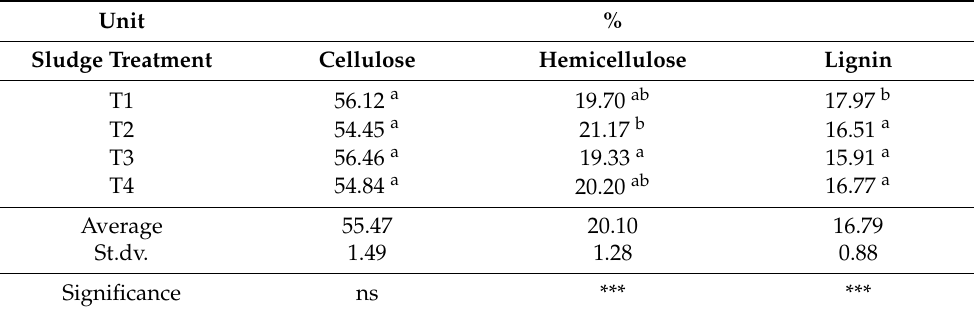
Table 7. Structural composition of Virginia mallow biomass after application of different amounts of sewage